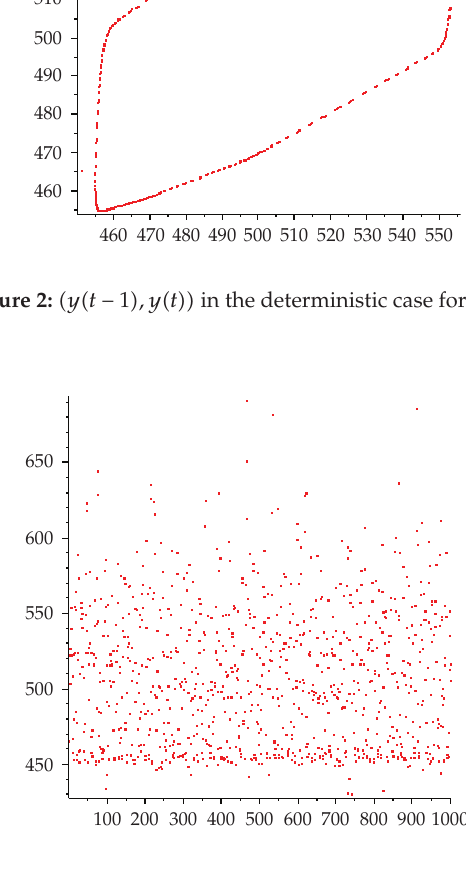
Figure 3: (cid:2) t,y (cid:2) t (cid:3)(cid:3) in the stochastic case for d (cid:7)